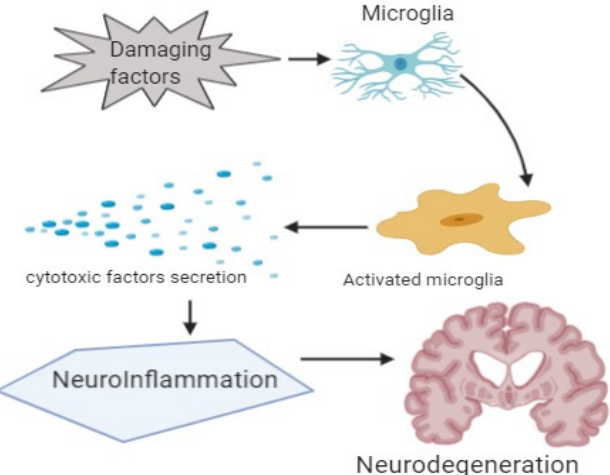
Figure 3. Showing graphical abstract.